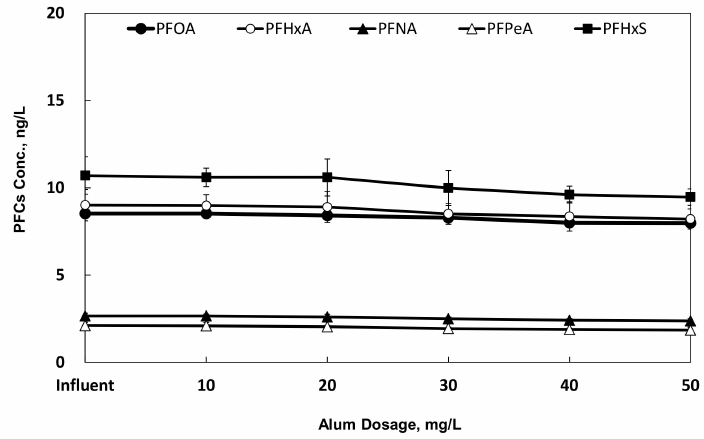
Figure 3. Variations in PFCs concentrations with Alum